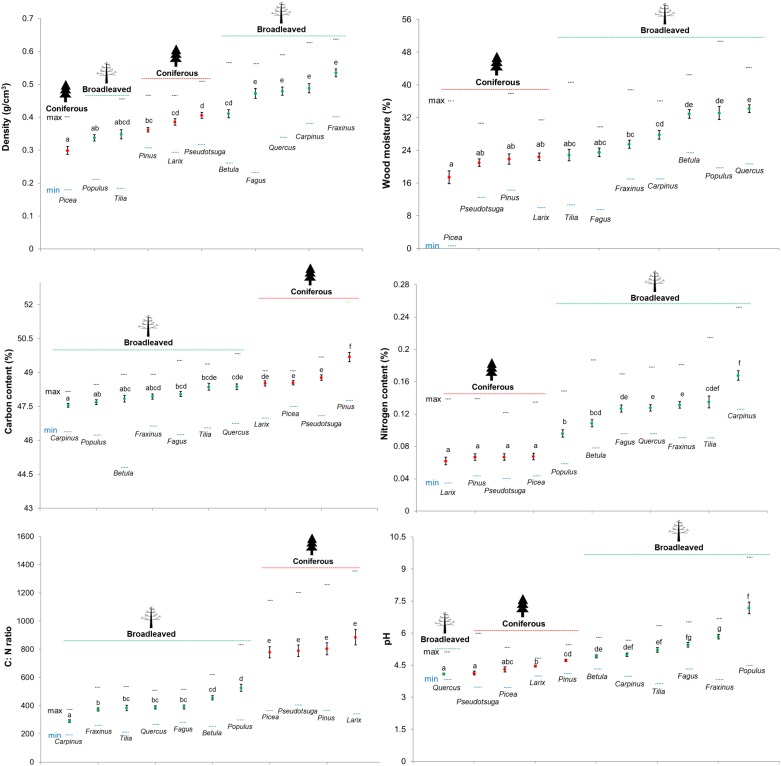
Wood physicochemical properties of deadwood logs decomposing for 3 years across 11 tree species (green = broadleaved tree species and red = coniferous tree species) in 27 forest plots (mean ± SE, n = 27). The maximum and minimum values are represented by the orange and blue dotted lines, respectively.